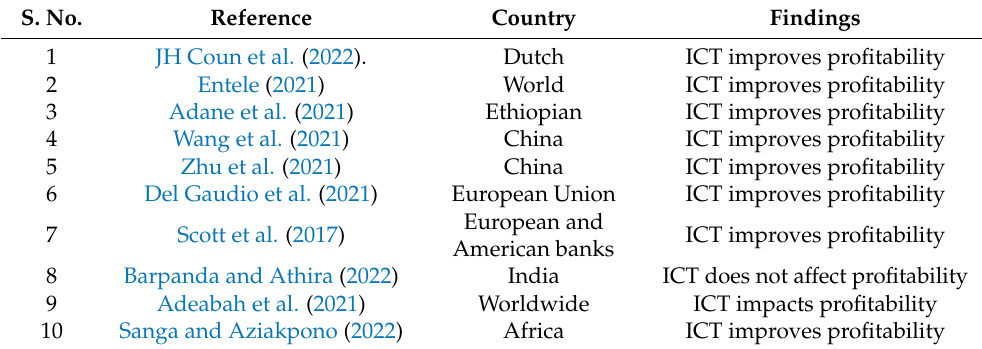
Table A1. Literature Review summary of important